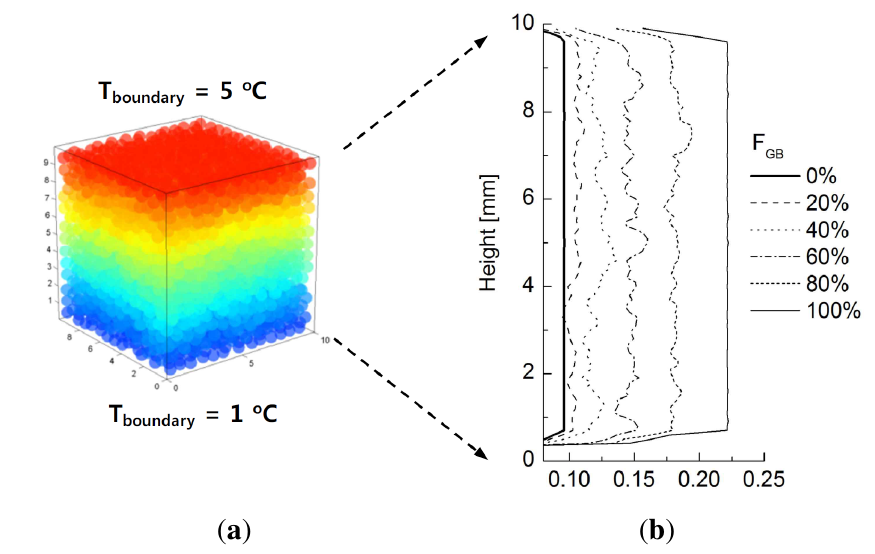
= 60% in Case 1 GB